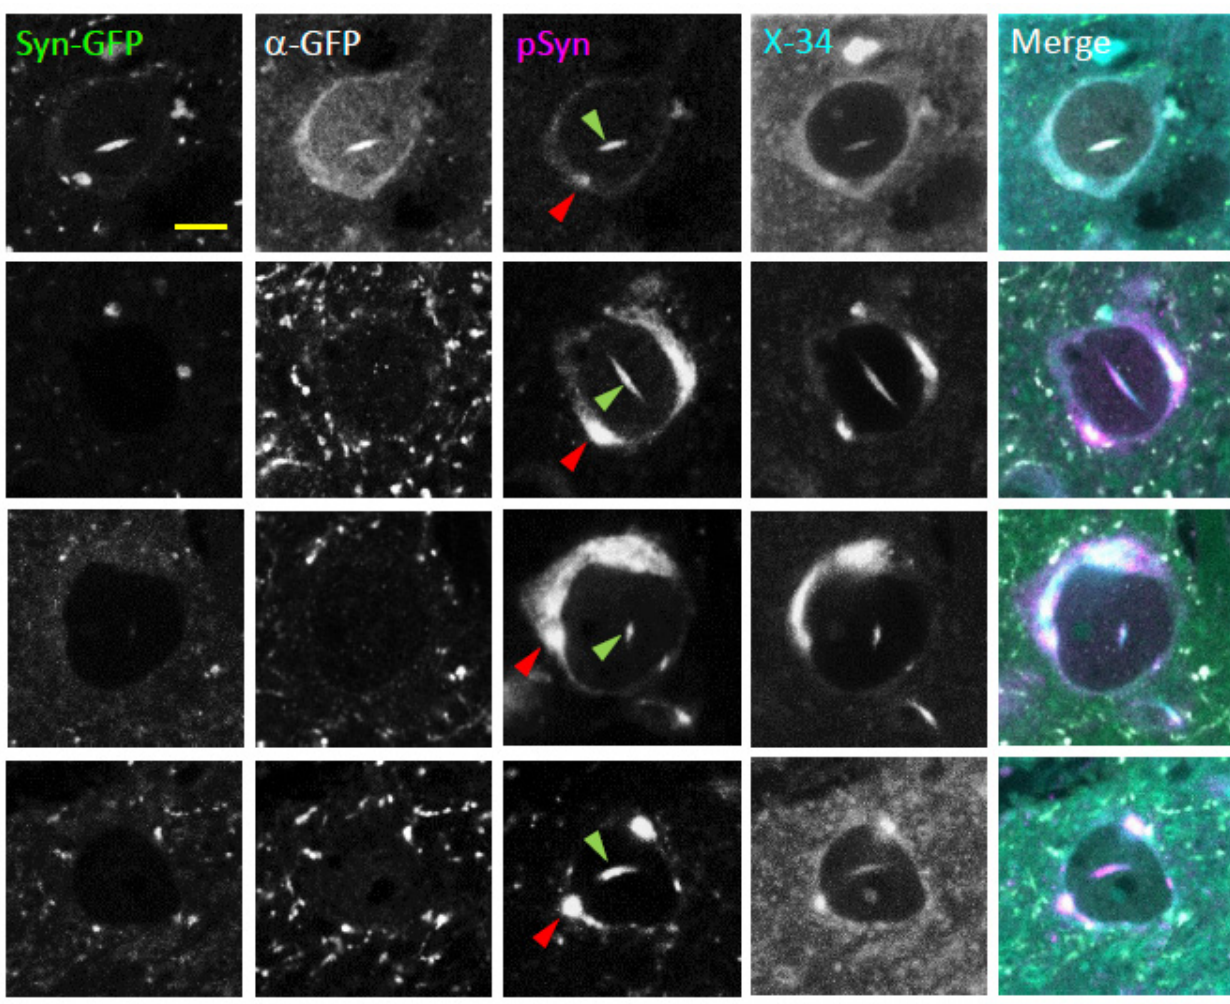
Figure 3. Intranuclear alpha-synuclein aggregates in neurons bearing somatic Lewy pathology are phosphorylated at serine-129 and in an amyloid fibril state. Confocal imaging in fixed tissue from PFF-injected Syn-GFP transgenic animals induced to form Lewy pathology shows four examples of somatic (red arrowhead) and intranuclear (green arrowhead) inclusions (each row a different cell) imaged for endogenous GFP fluorescence (Syn-GFP), with an anti-GFP antibody ( α -GFP), with a serine-129 phospho-synuclein antibody (pSyn), and for fluorescence from the dye X-34 that labels fibrillar proteins in an amyloid conformation. Top row : Syn-GFP-expressing neuron. Bottom three rows : Syn-GFP-negative neurons only expressing endogenous mouse alpha-synuclein. Scale bar: 5 μ m.